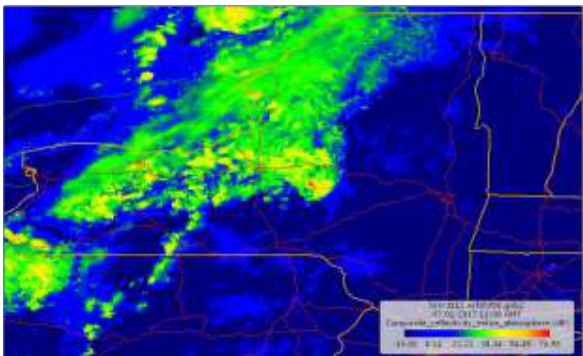
Figure 10. Composite reflectivity. 10Z July 1, 2017 showing severe weather approaching Central New York.